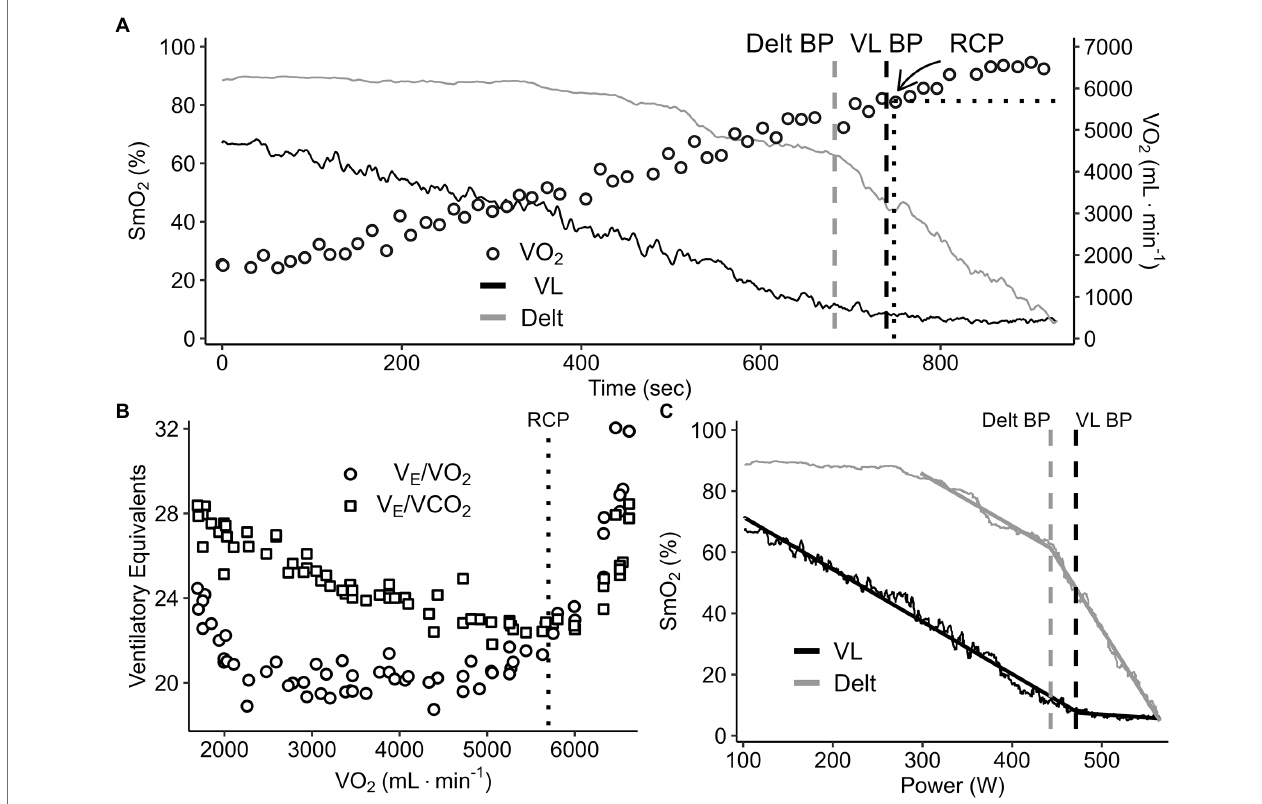
FIGURE 2 | A representative data set of breakpoint detection and comparison between the change in %SmO 2 (VL and deltoid) and V ̇ O 2 (panel A ), ventilatory equivalents of O